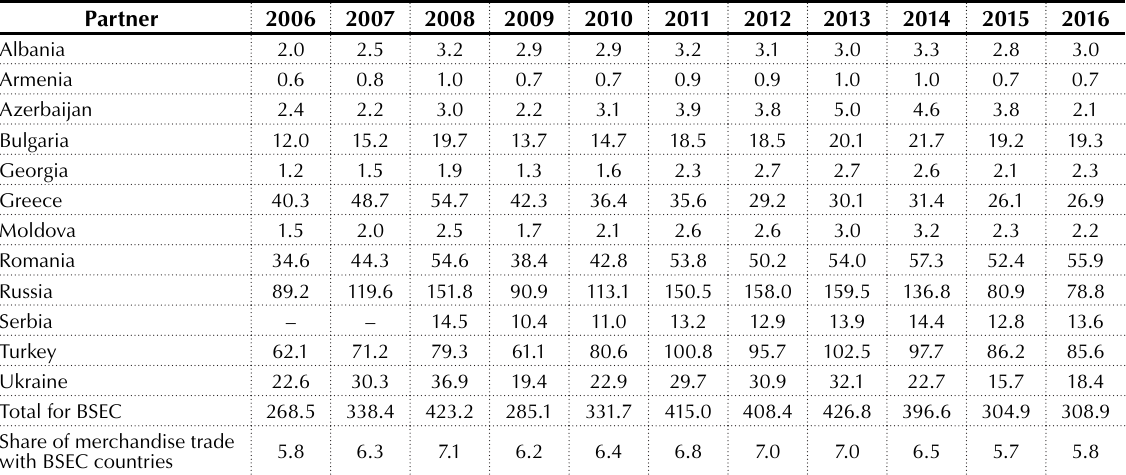
Source: UNCTAD and authors’